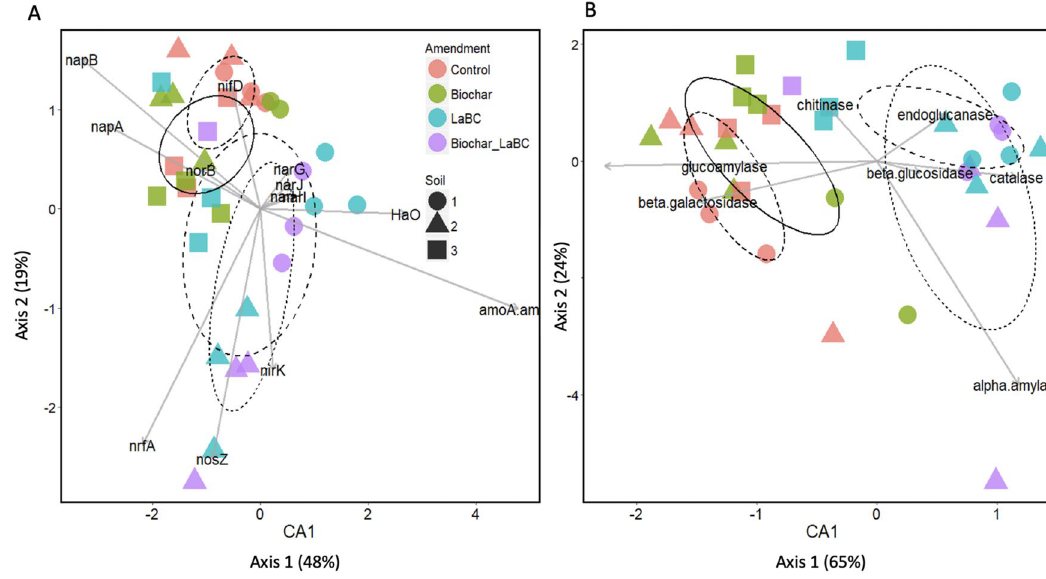
Figure 4. Canonical correspondence analysis (CCA) biplot showing the relationship between predicted gene count (PICRUSt) of N ( A ) and C cycling genes ( B ) and soil amendments for three soils of contrasting textures (Soils 1, 2, 3; sand, sandy loam and clay respectively) amended with LaBC, Biochar and Biochar + LaBC after 8 weeks with subterranean clover. The following C cycling genes that encode for specific enzymes included: amyA (α-amylase), SusB (glucoamylase), LacZ (β-galactosidase), bglx (β-glucosidase), SrpA (catalase), ChiC (chitinase) and bcsZ (endoglucanase). The following N cycling genes that encode for specific enzymes included: nitrogen fixing gene nifD (nitrogenase); nitrifying genes amoA/amoB (ammonia monooxygenase) and Hao (hydroxylamine oxidoreductase) and denitrifying genes norB (nitric oxide reductase), narG (nitrate reductase), nirK (nitrite reductase), nosZ (nitrous oxide) and nrfA (nitrite reductase–ammonium forming). Arrows represent the measured variables (pH, NH 4 + , MBN). The ellipses show how the samples separate according to treatment.